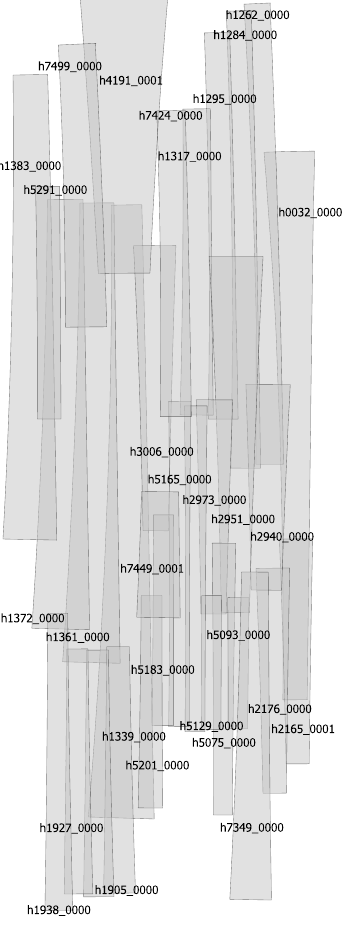
Figure 5: Nadir image footprints of a Block of 32 HRSC strips